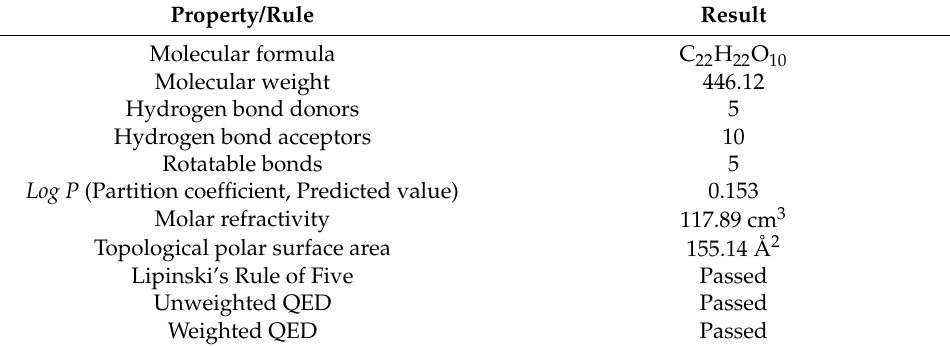
Table 3. Physicochemical and drug-likeness properties of tilianin.